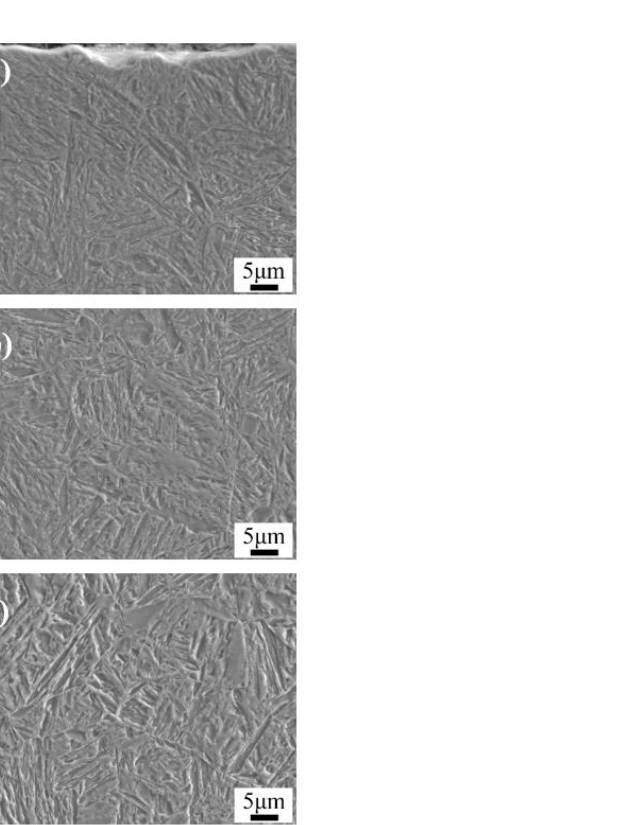
Figure 5. Optical micrographs of the microstructures after low-temperature tempering: ( a ) the surface; ( b ) the subsurface; and ( c ) the core. Materials 2020 , 13 , x FOR PEER REVIEW